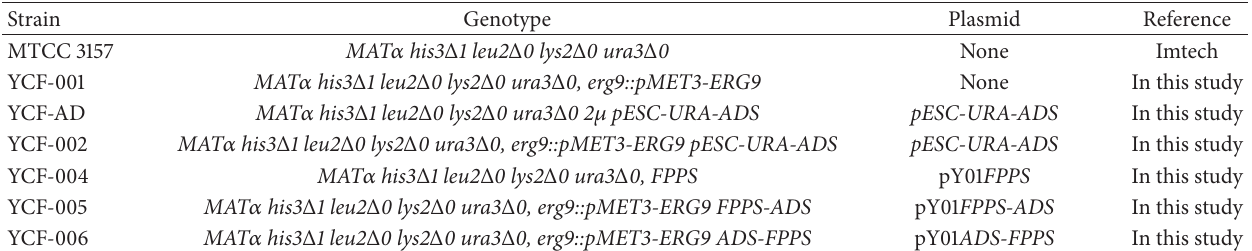
Table 2: Yeast strains and plasmids used in this study.